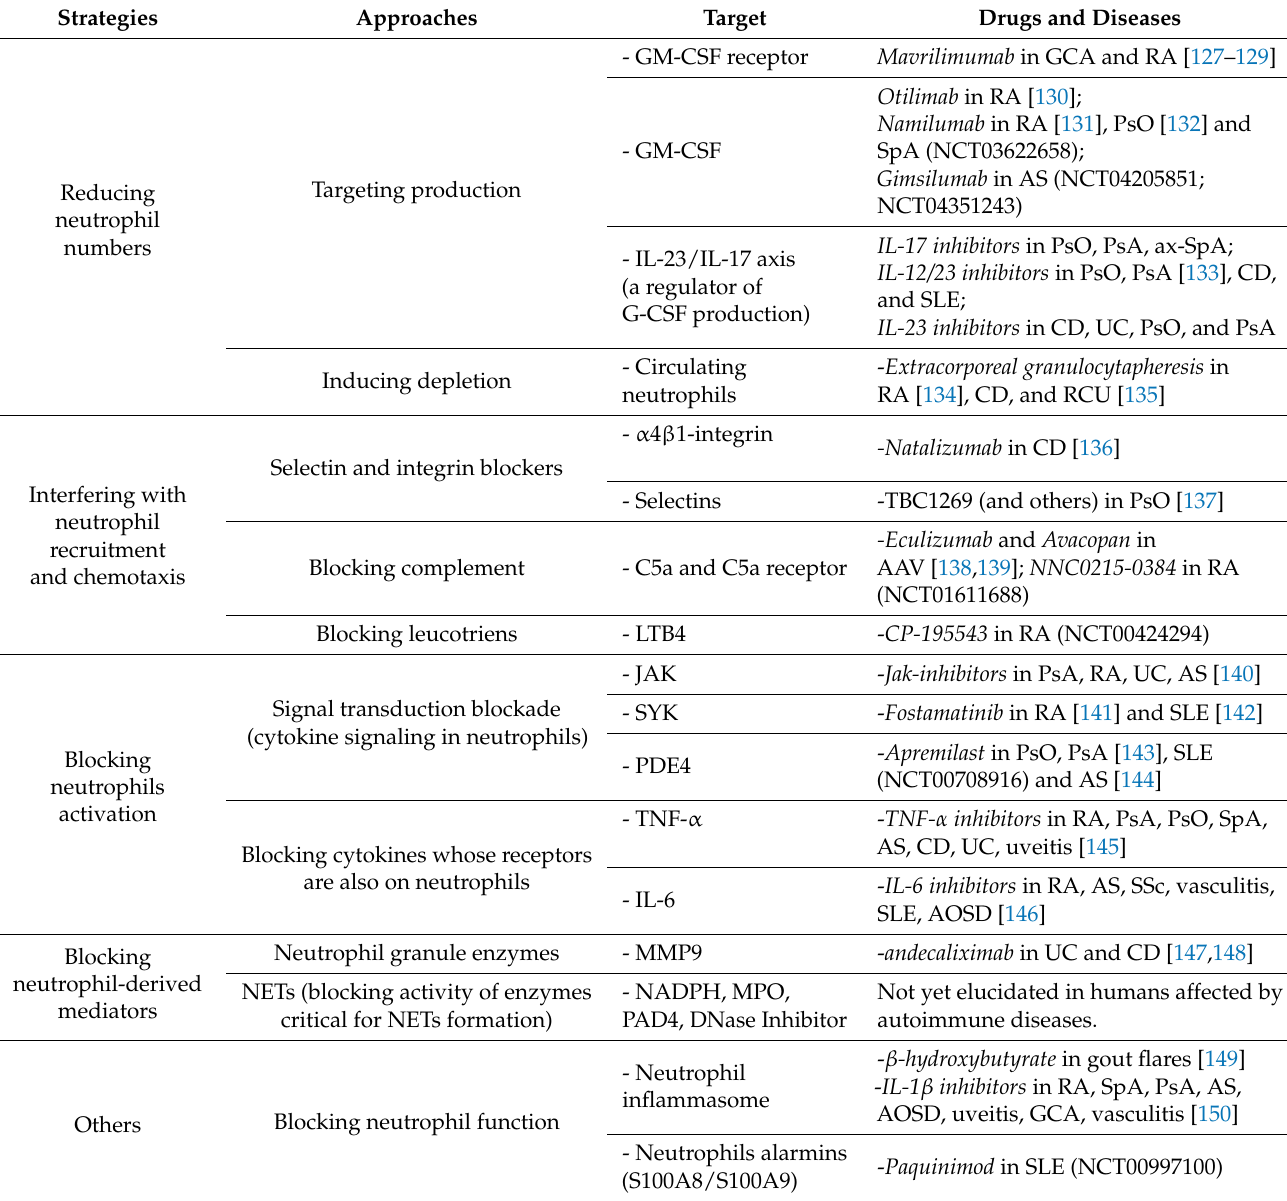
Table 1. Inhibition of neutrophils: therapeutic approaches in autoimmune